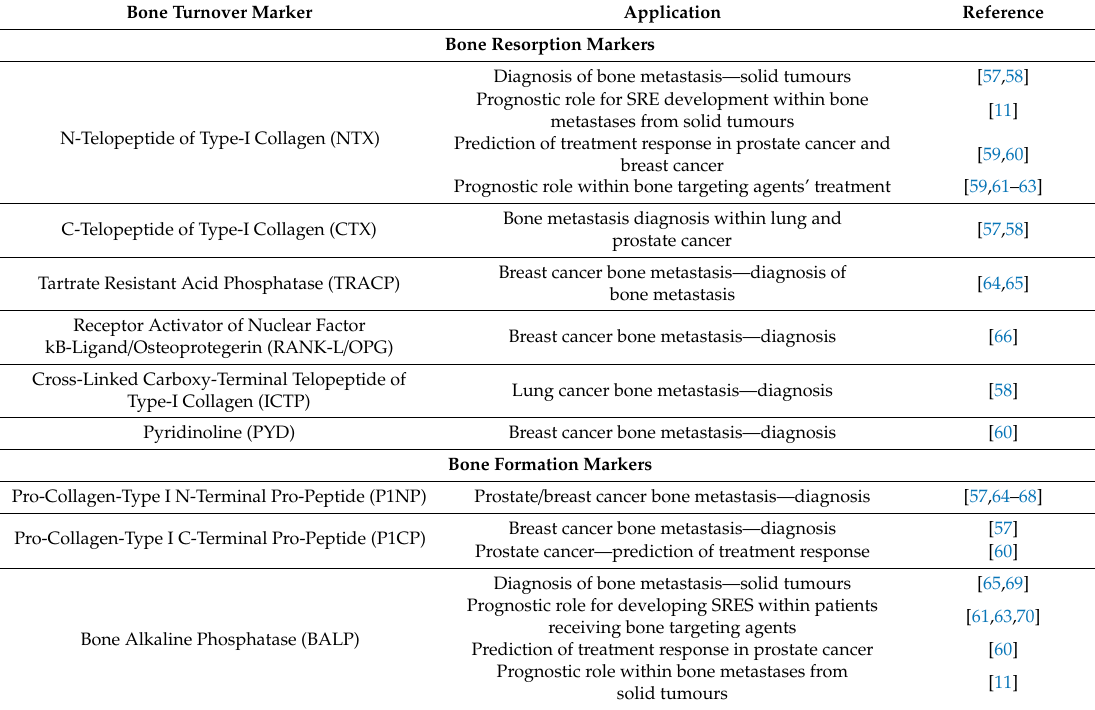
Table 2. Utility of bone turnover markers (BTMs) within bone metastasis.